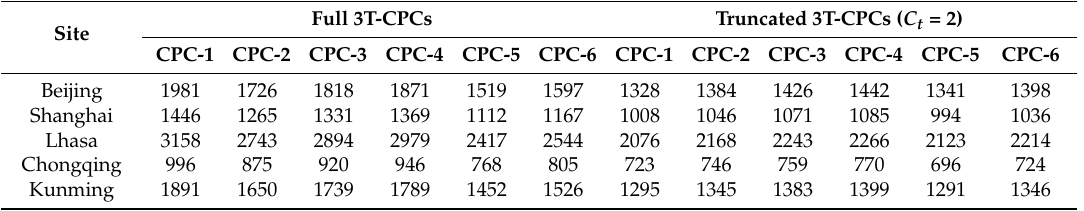
Table 6. Annual radiation on EST of 3T ‐ CPCs with θ a = 20° and ρ = 0.92 (MJ/m). Site